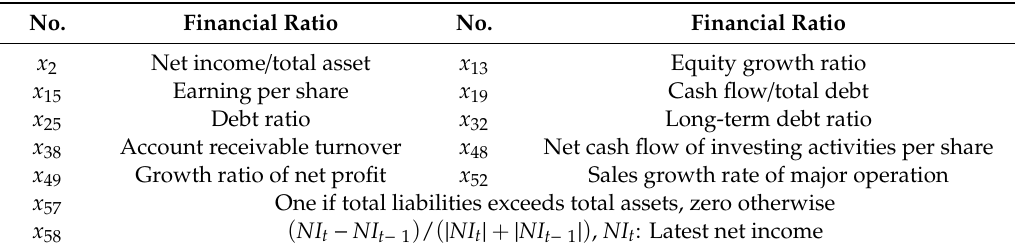
Table 3. Financial ratios selected using the comprehensive training data set of the year ( t − 2 ) . No. No.